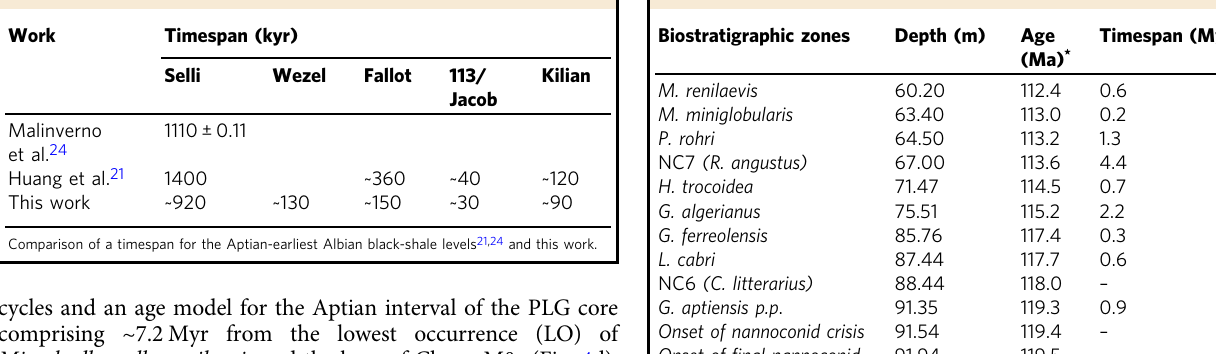
Table 1 Estimated timespan of Aptian events. Table 2 Estimated timespan of